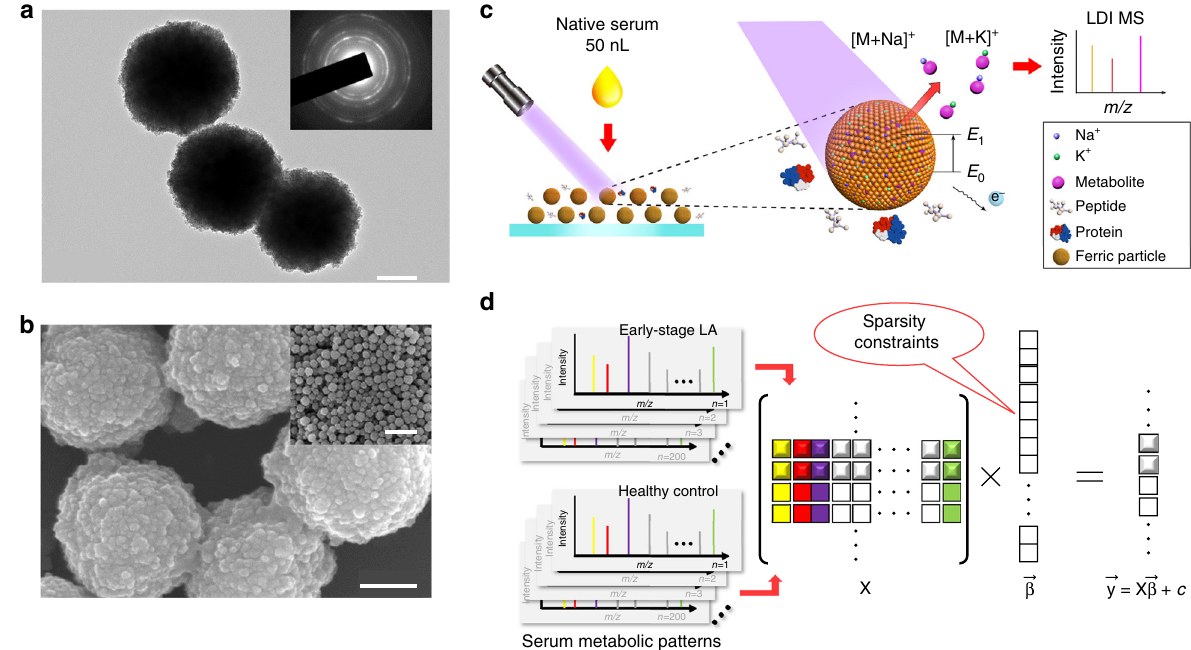
Fig. 1 Substrate material characteristics and schematics of extraction and machine-learning work fl ow. a Transmission electron microscopy (TEM) image of ferric particles ( n ≥ 3 randomly selected) and selected area electron diffraction (SAED) pattern (inset) showing polycrystalline structure. Scale bar = 100 nm. b Scanning electron microscopy (SEM) images ( n ≥ 3 randomly selected) of ferric particles showing nanoscale surface roughness and large- scale uniformity (inset). Scale bars = 100 nm in b and 1 μ m in the inset of b . c Schematic work fl ow for the extraction of serum metabolic patterns by ferric particle-assisted laser desorption/ionization mass spectrometry (LDI MS). Fifty nanolitres of native serum was consumed for direct analysis without pre- treatment procedures. Only Na + -adducted and K + -adducted metabolites can be selectively detected with the coexistence of high concentration of peptides and proteins. d Schematic outline for the sparse regression machine learning of serum metabolic patterns (X). The sparse regression method was ! used to build calculation models with sparsely constrained (cid:1) β towards the diagnosis of early-stage LA ( y ). Each square and its colour in X corresponded to one m / z feature and its signal intensity in serum metabolic